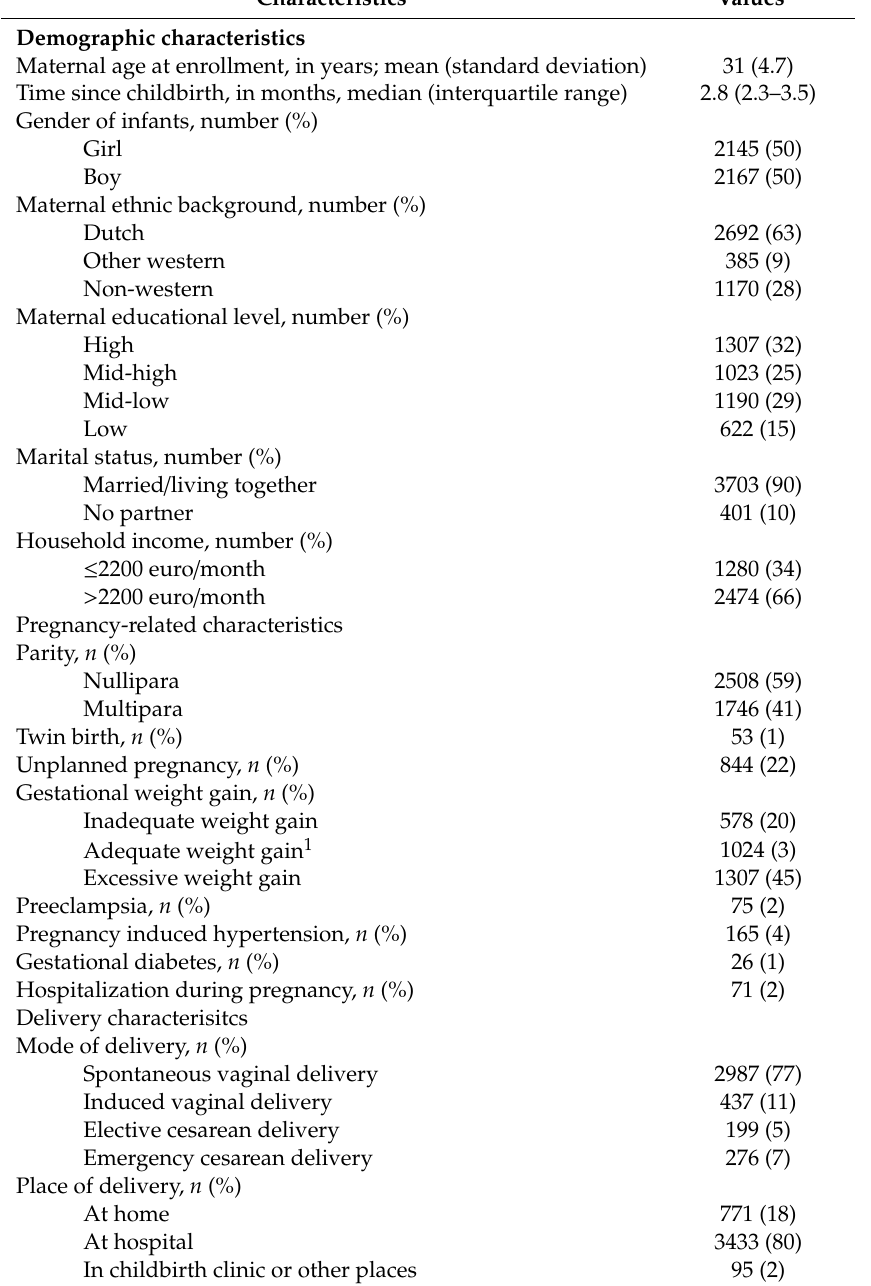
Table 1. Characteristics of mothers and infants ( n =